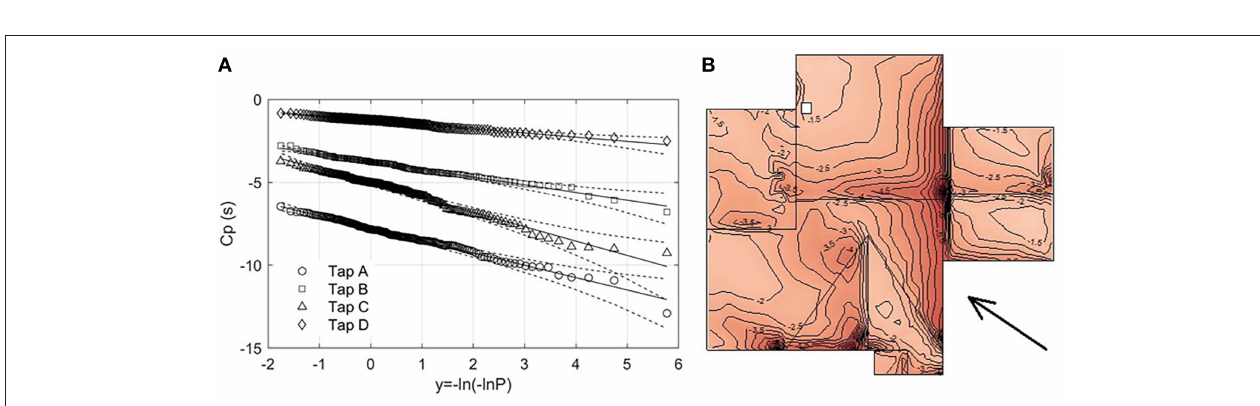
FIGURE 7 | Datum extreme-value analysis: (A) Gumbel plot for Taps A to D, T = 10min FS, (B) Distribution of 78% Cp , T = 1 h FS.